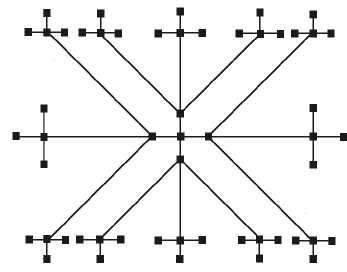
Figure 3: The representation of Cayley tree 𝐶 4,3 is illustrated.